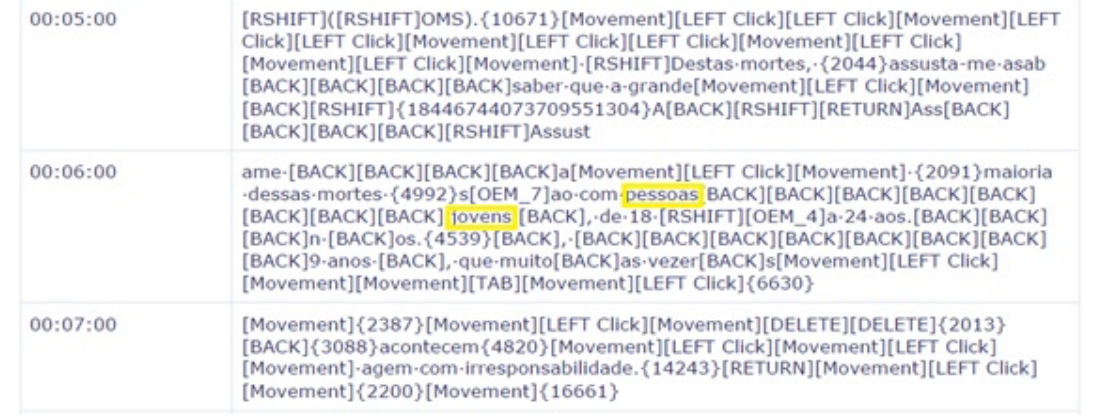
Figure 1 Transcription provided by